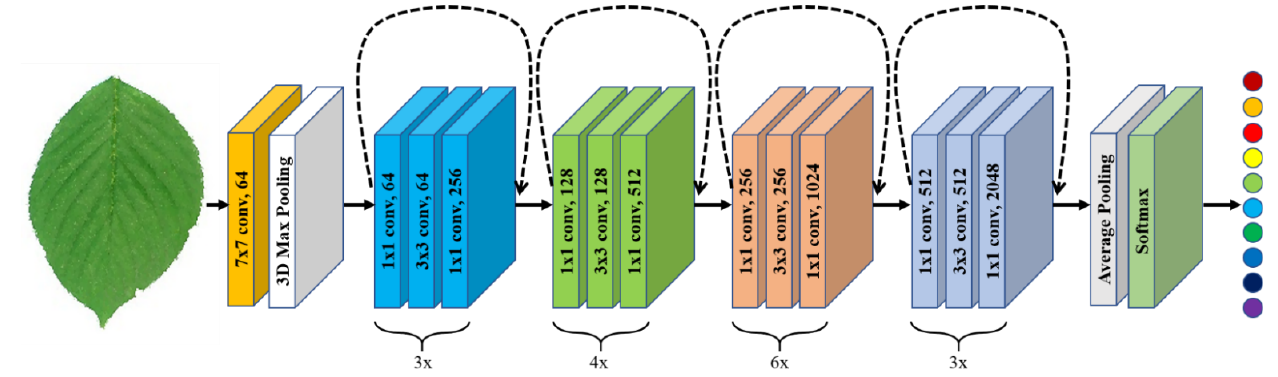
Figure 18. Showing the residual identity mapping for a residual neural network.